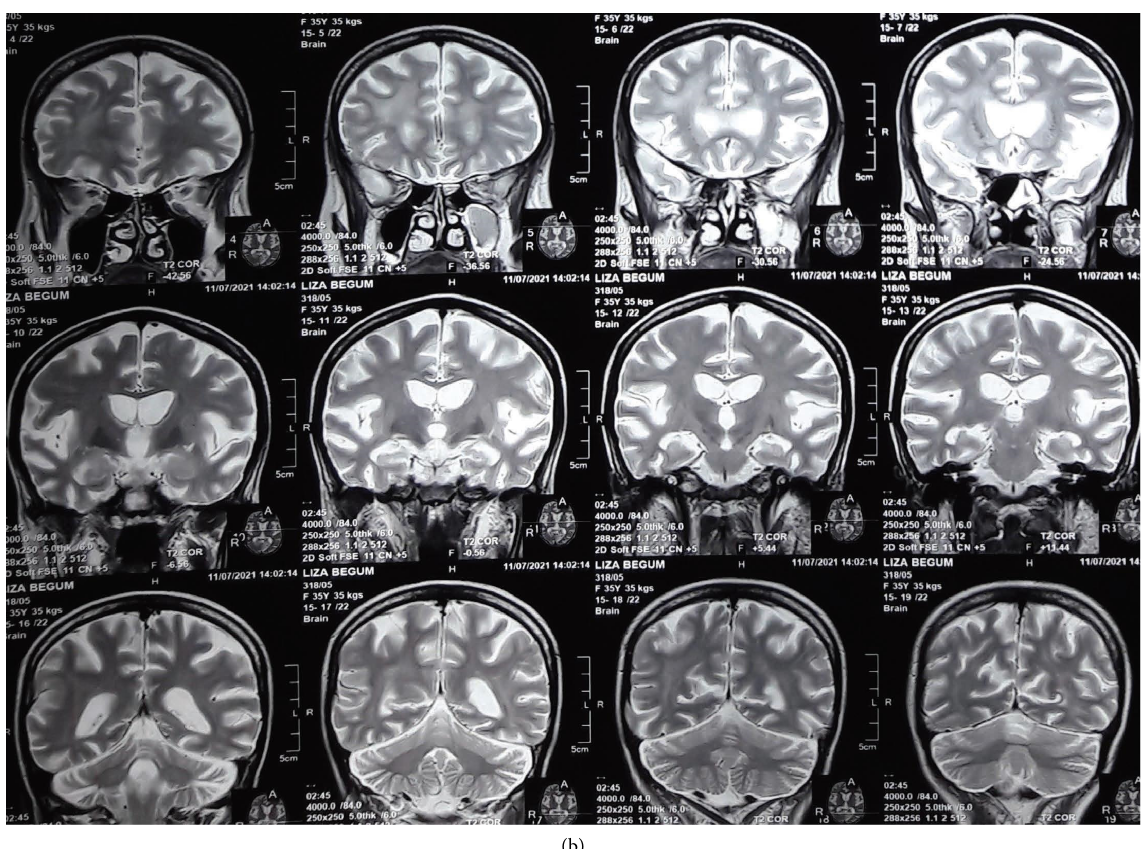
Figure 1: MRI brain: (a) T1 axial view and (b) T2 coronal view, showing generalized brain